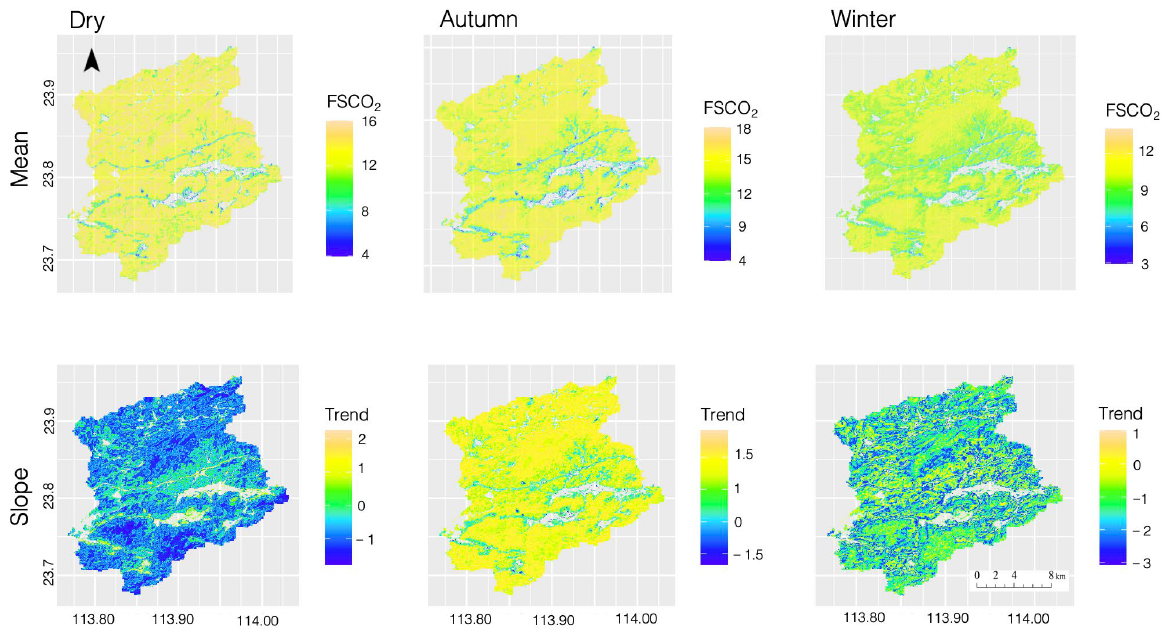
Figure 9. The spatiotemporal distribution patterns of the mean (Unit: g C m −2 day −1 ) and trend values of FSCO 2 in the subtropical forest in dry seasons.